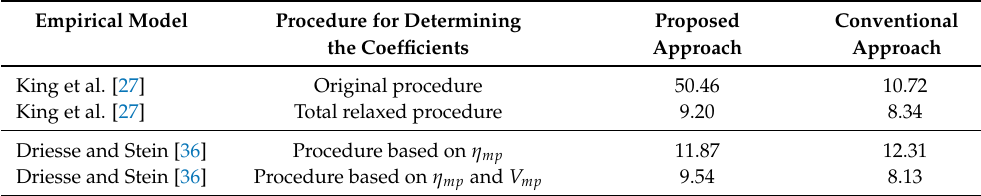
Table A3. RMSE values (%) calculated from the global results obtained by the empirical models proposed by King et al. [27] and Driesse and Stein [36], in each tested procedure to determine their respective